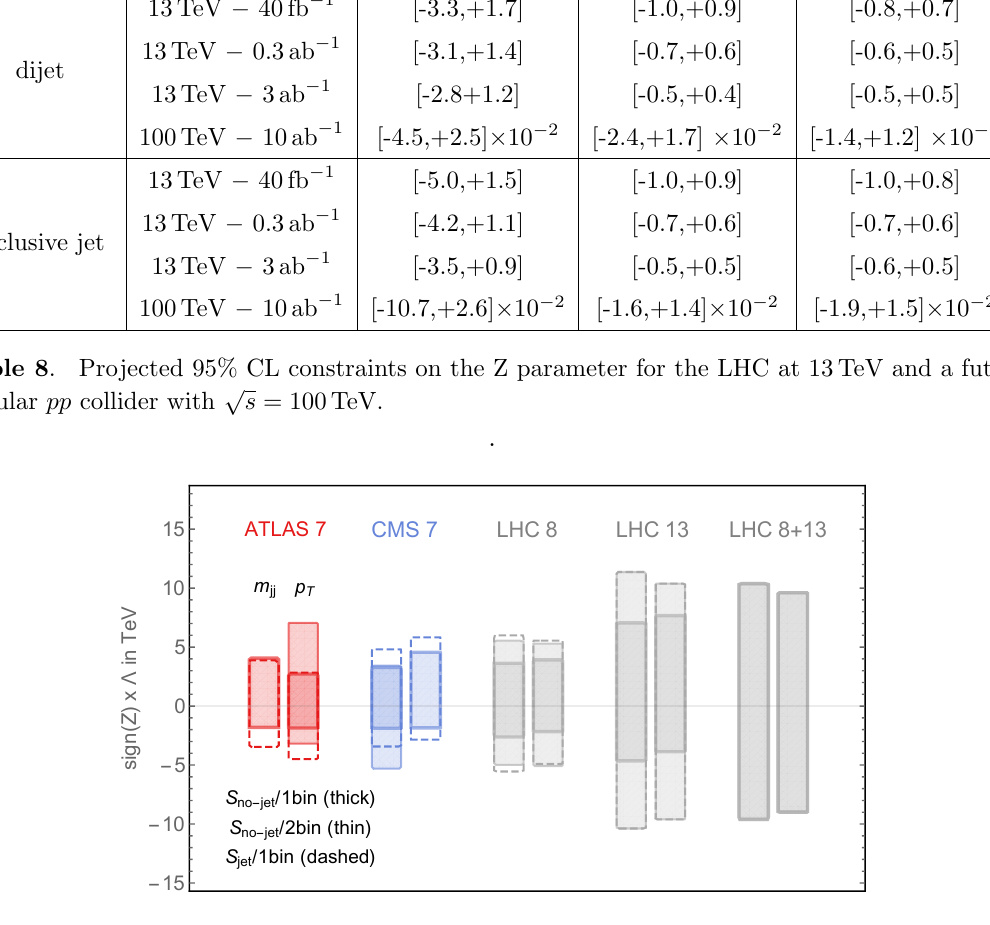
Figure 12 . Summary of our results at the LHC, in terms of the NP scale (cid:3), de(cid:12)ned as (cid:3) (cid:17) p m W = j Z j . For the 8 TeV LHC we assume an integrated luminosity of 20 fb (cid:0) 1 , while we use 300 fb (cid:0) 1 for the LHC at 13 TeV. Red and blue correspond to (cid:12)ts to ATLAS and CMS data, respectively, whereas gray corresponds to future projections at 8 and 13